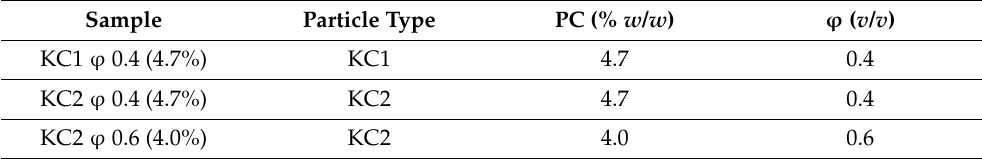
Table 7. Formulation of the produced Pickering